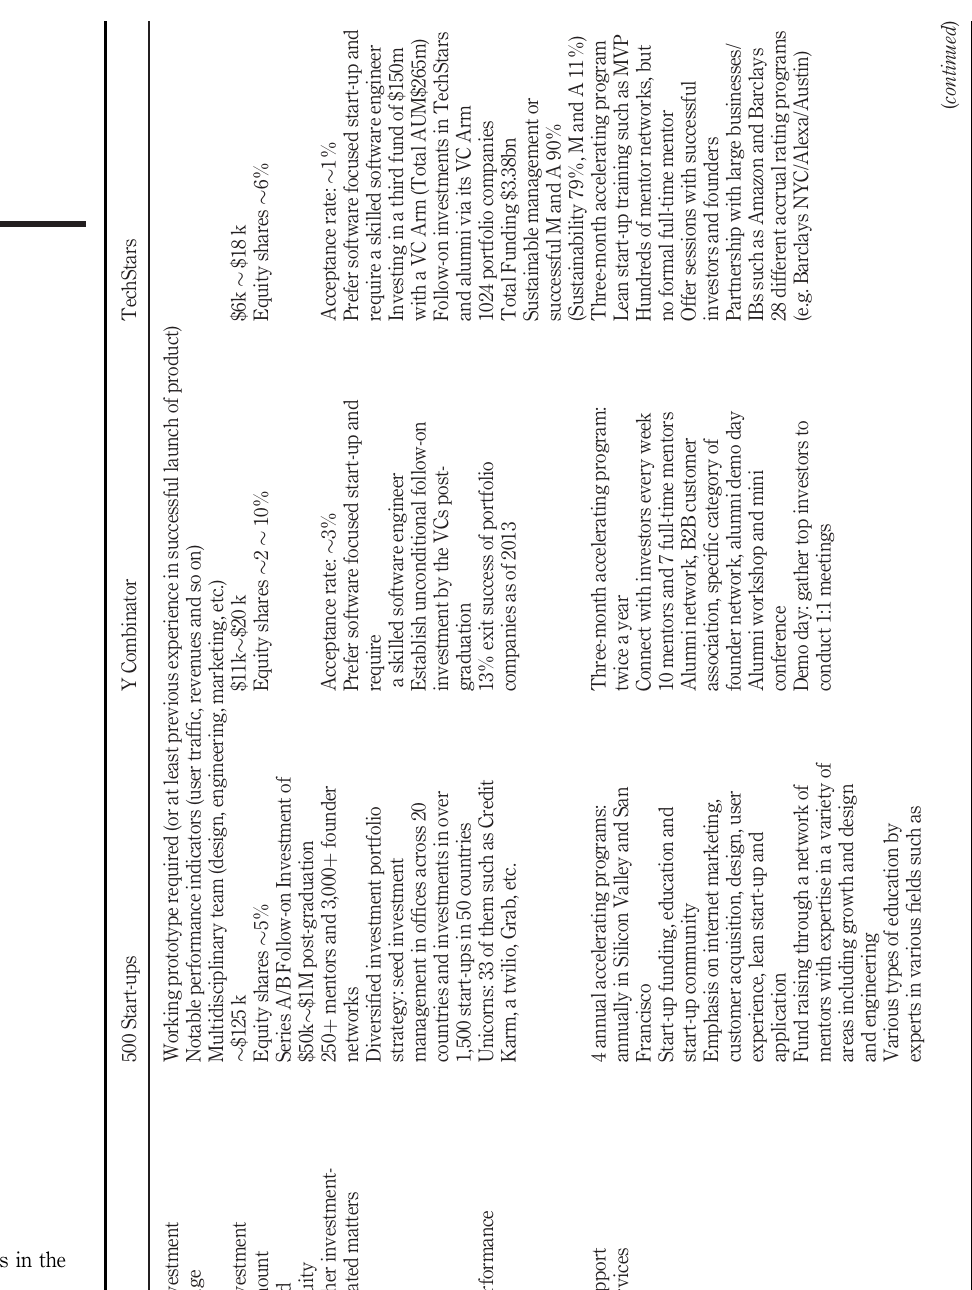
Table IV. Accelerators in the USA